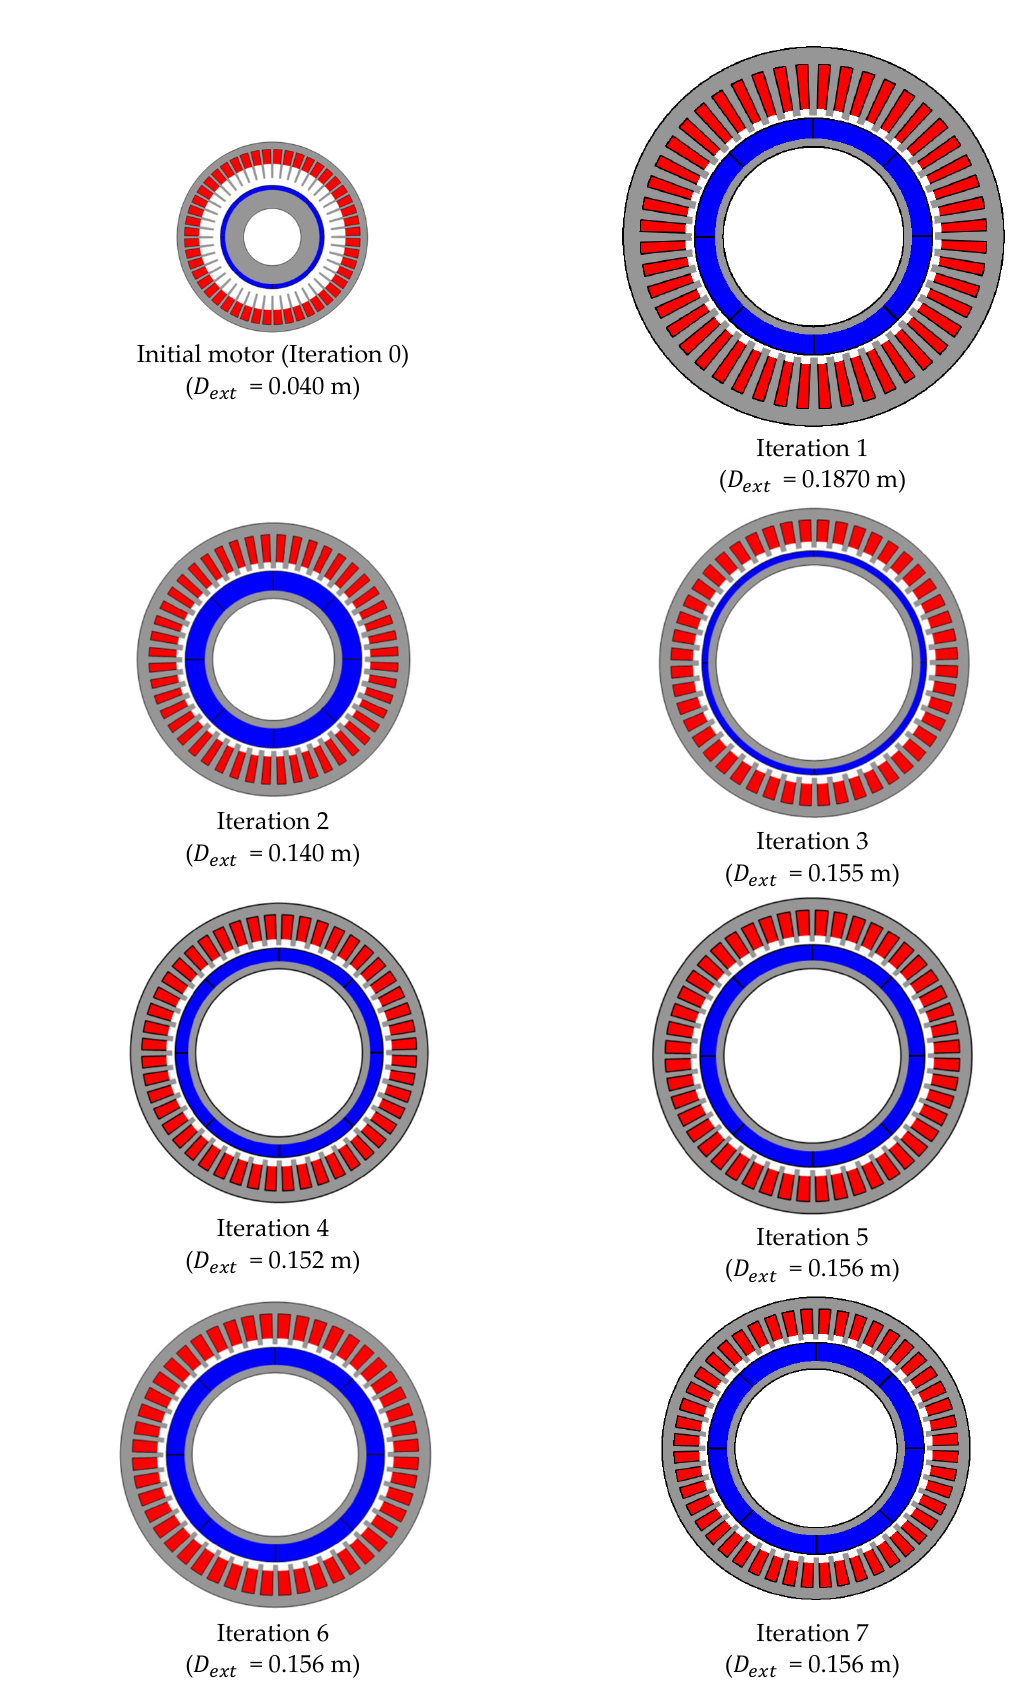
Figure 12. Machine geometries for each iteration.